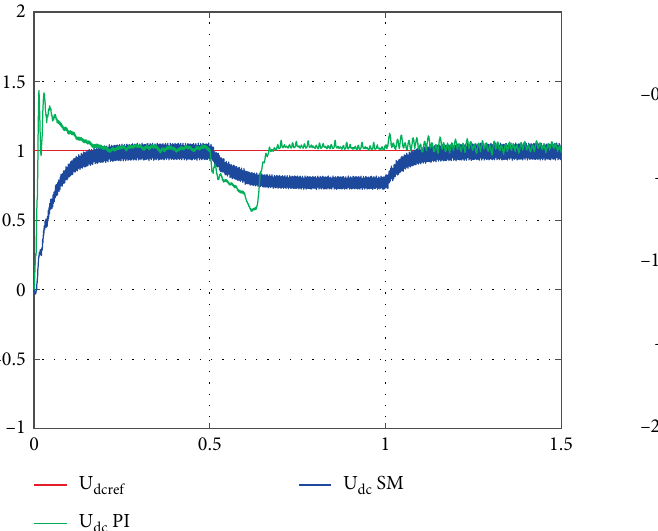
Figure 16: Active power with 20% depth of stator voltage.